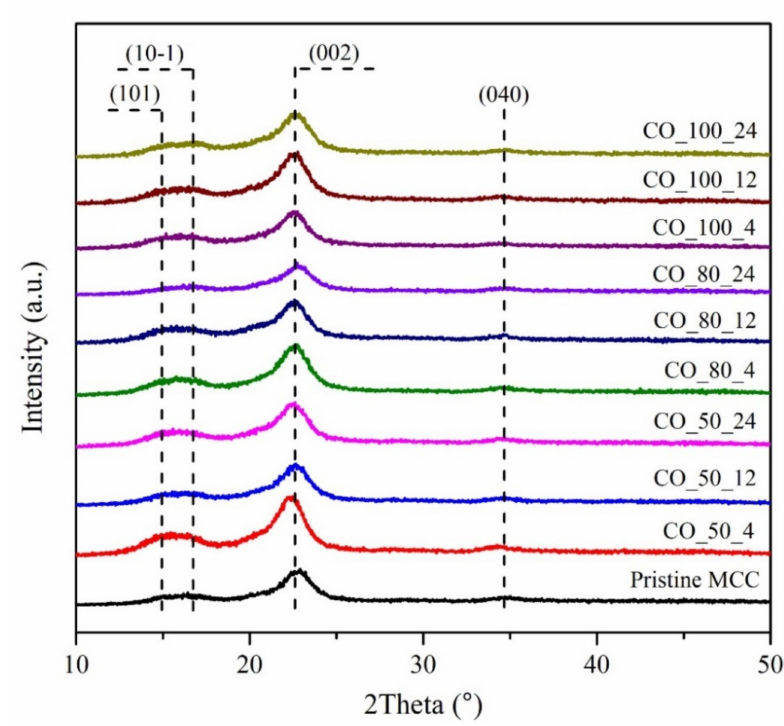
Figure 4. X-ray diffractograms patterns of MCC and modified cellulose (COs). The pristine cellulose and mechanochemical-treated cellulose showed the main re- flection peaks at around 2 θ = 14.8 ◦ , 16.4 ◦ , 22.7 ◦ , and 34.7 ◦ , which are normally ascribed to the (101), (101), (002), and (040) diffraction planes, respectively. Based on the diffraction peak angles, they were exhibited characteristic peaks as cellulose I. The XRD patterns of modified cellulose remained unchanged in comparison to the microcrystalline cellulose, indicating that the reaction only partially took place without affecting the inner struc- ture of cellulose [29]. The modification is posited to occur at the amorphous regions of the cellulose. The crystallinity index (CrI), full width at half maximum (FWHM), and crystallite size of each sample were calculated according to their corresponding XRD diffractogram. The results are presented in Table